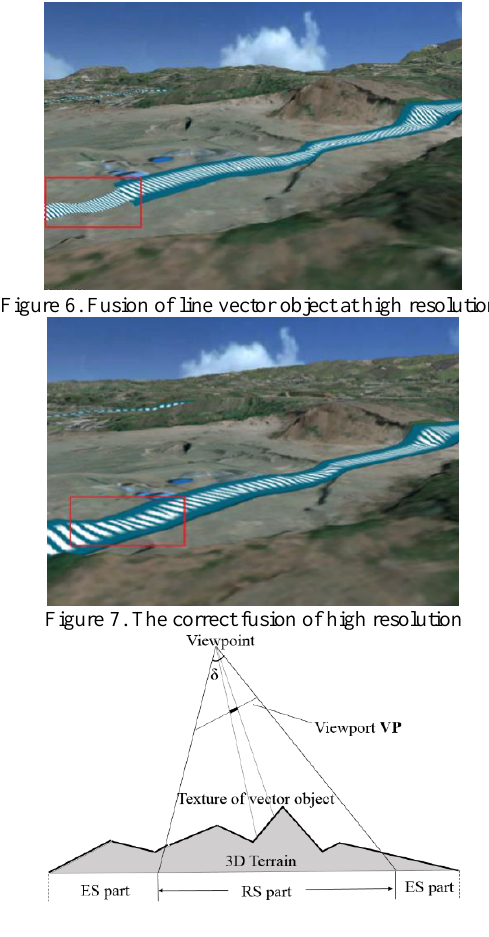
Table 1. Agg and GDI+ performance comparison